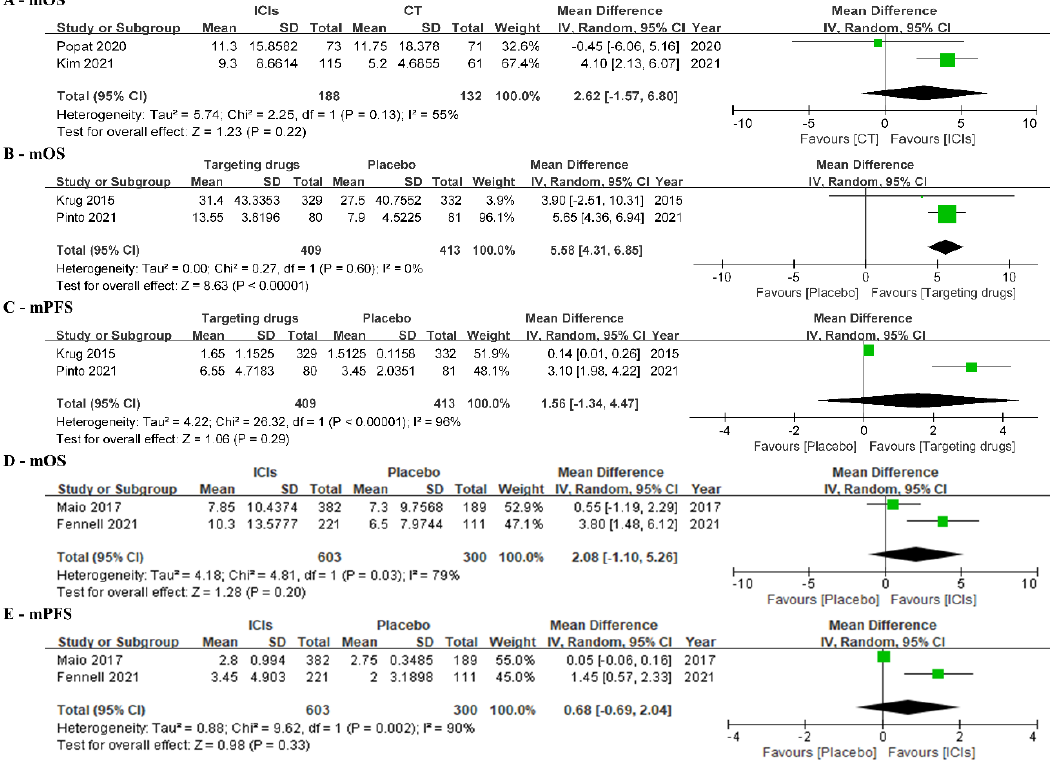
Figure 4. ( A ) Forest plot of mOS between ICIs and chemotherapy. ( B ) Forest plot of mOS between targeting drugs and placebo. ( C ) Forest plot of mPFS between targeting drugs and placebo. ( D ) Forest plot of mOS between ICIs and placebo. ( E ) Forest plot of mPFS between ICIs and placebo [26,31,42,44,45,48] .